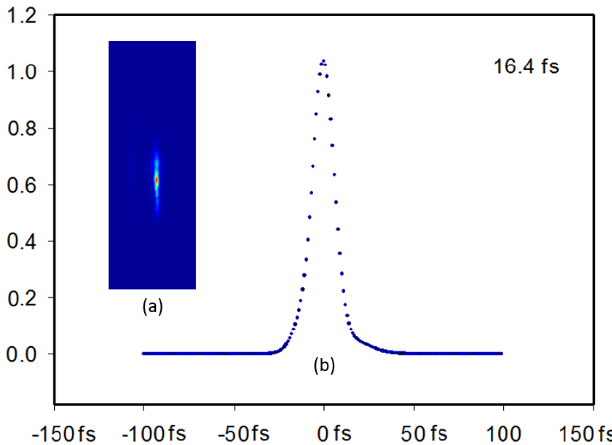
Figure 5. Auto-correlation trace of the compressed seed pulse by a single-shot femtosecond auto- correlator.